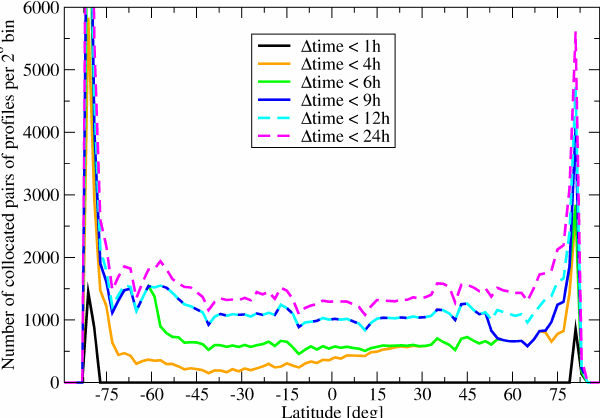
Figure 2. Latitudinal coverage of collocated points for (cid:49) dist < 1 ◦ and different limits for (cid:49) time.